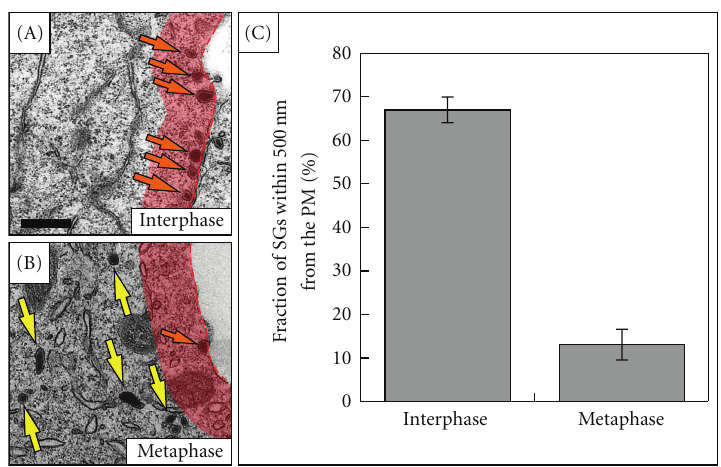
Figure 2: Statistical analysis of the amount of peripheral SGs in interphase and metaphase PC12 cells. The red translucent stripe in (A) and (B) images indicates a peripheral region adjacent to the PM, whose thickness is 500 nm. Arrows in (A) and (B) point to SGs that lie within the marked region (orange arrows) and SGs that do not belong to the marked region (yellow arrows). The graph in (C) summarizes a quantification of the fraction of SGs within the cortical 500 nm region of three interphase and three metaphase cells from di ff erent EM preparations. In interphase cells, 70 ± 3% of the total number of SGs ( n = 227) were within the cortical region, compared to only 13 ± 4% of total SGs ( n = 376) in metaphase cells ( P = 0 . 0008, Student’s t -test). Error bars in (C) represent standard deviations. Scale bar, 500 nm.